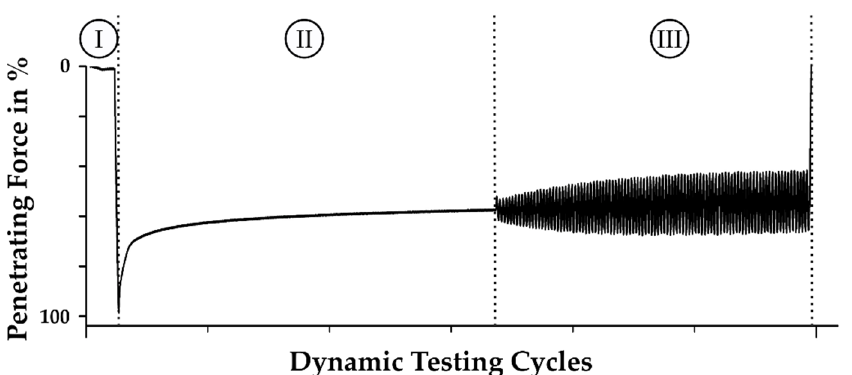
Figure 4. Test sequence for the DMA measurements, starting with a sequence for (I) maximum penetration, followed by a sequence of (II) relaxation and (III) cycles of dynamical testing [20,21].